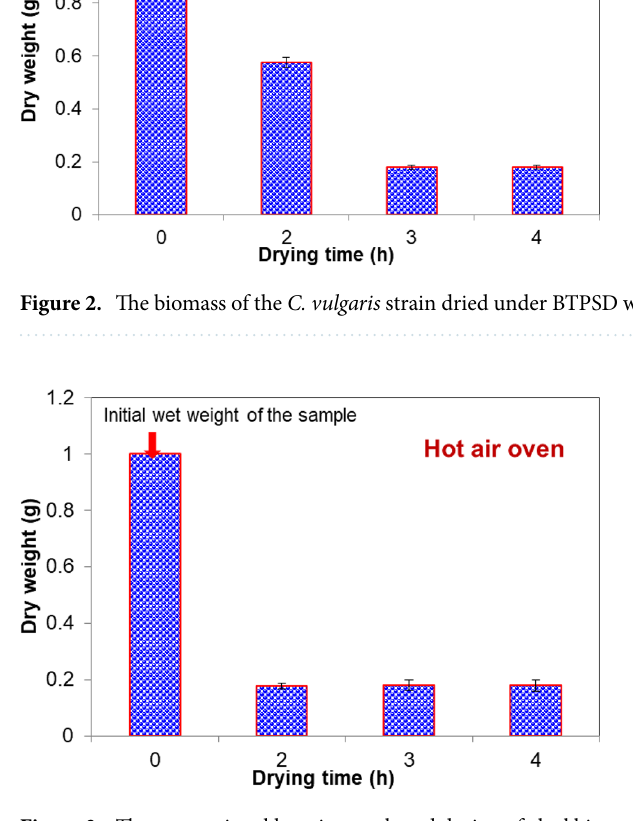
Figure 3. The conventional hot air oven based drying of algal biomass with respect to time